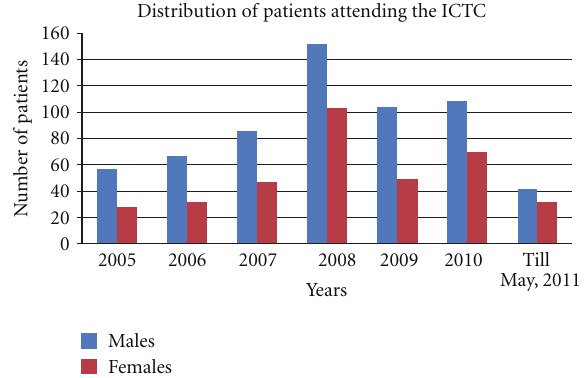
Figure 1: Distribution of participants seeking services at the ICTC across 6 years and 4 months.